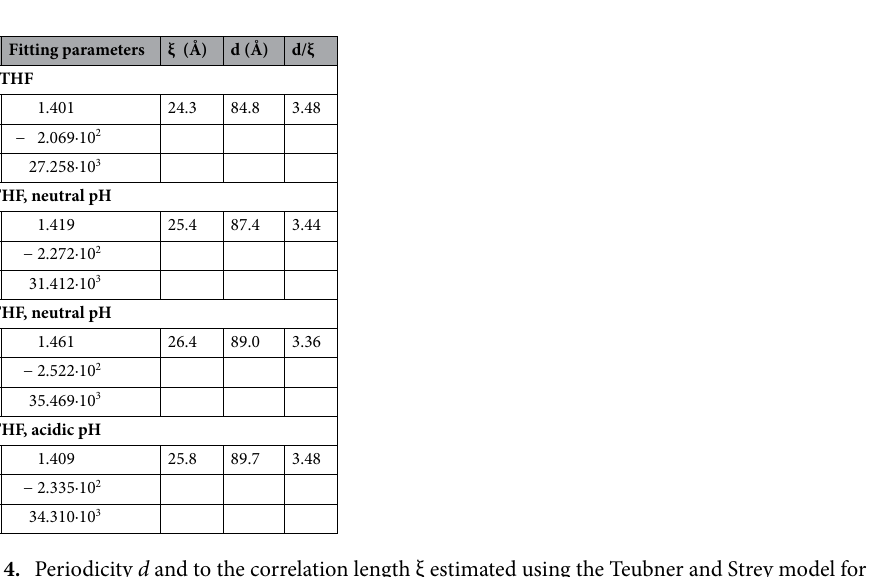
Table 4. Periodicity d and to the correlation length ξ estimated using the Teubner and Strey model for different samples containing lauric acid (500 g/L) in either THF (100% THF) or THF-water mixtures (with 90% or 95% THF relative to water, v/v), at neutral and acidic pH. The fitting parameters for the samples are also provided. Note the negative values of c 1 , typical of reverse micelles 85 .